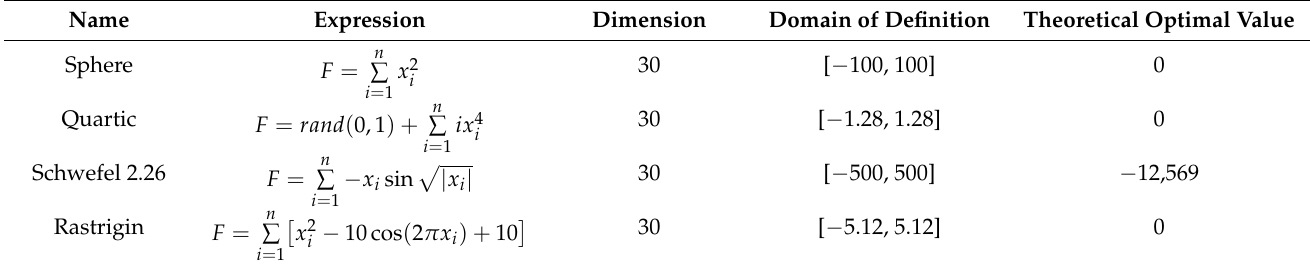
Table 1. Introduction to test